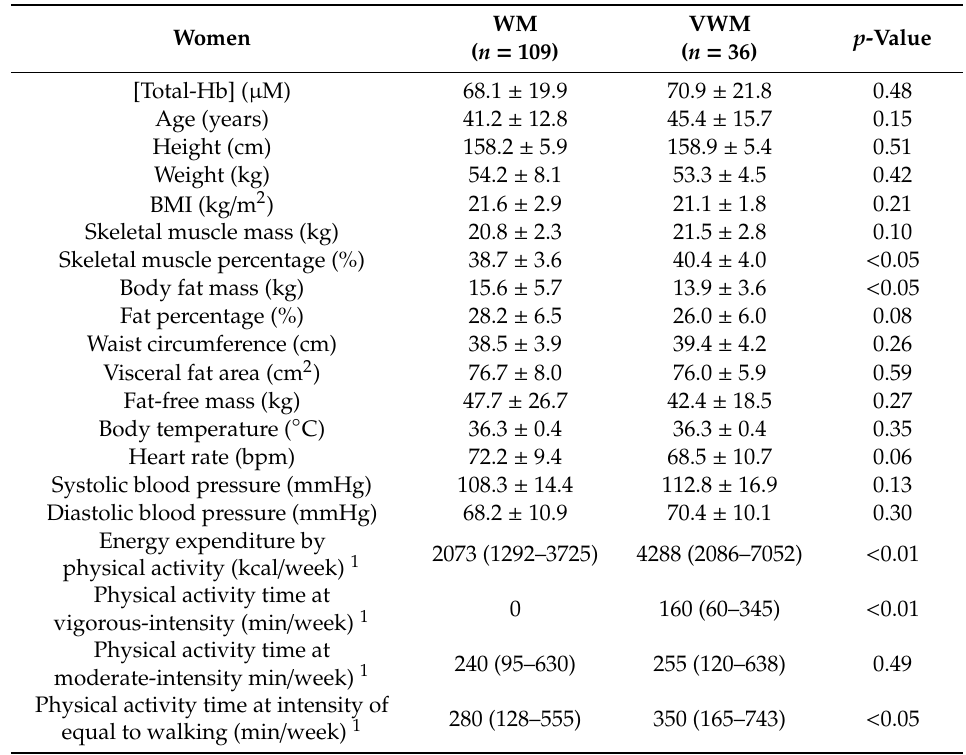
Table 2. Group comparison of each parameter in